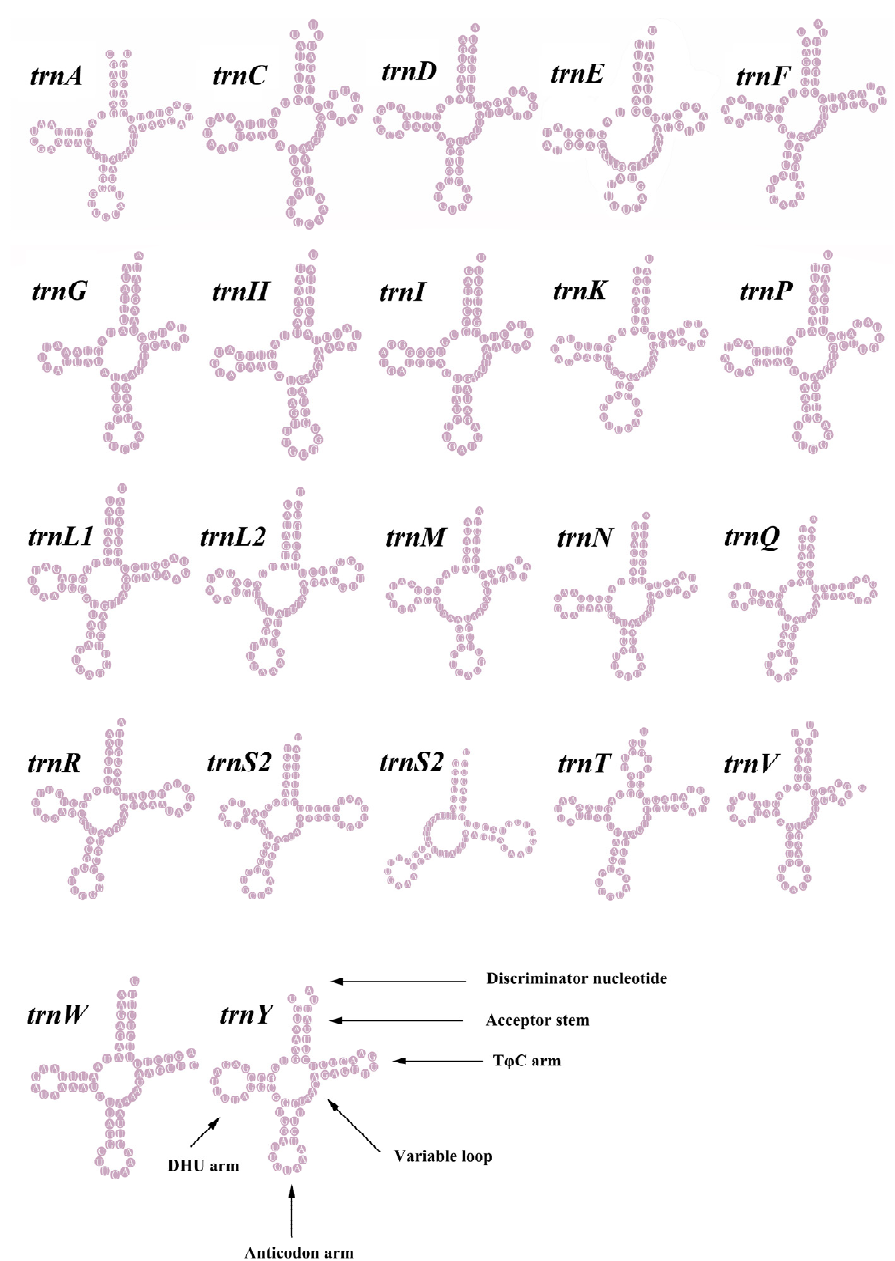
Figure 4. Putative secondary structures of the tRNA genes in the mitogenome of M. virgata . The tRNAs are labeled with the abbreviations of their corresponding amino acids.